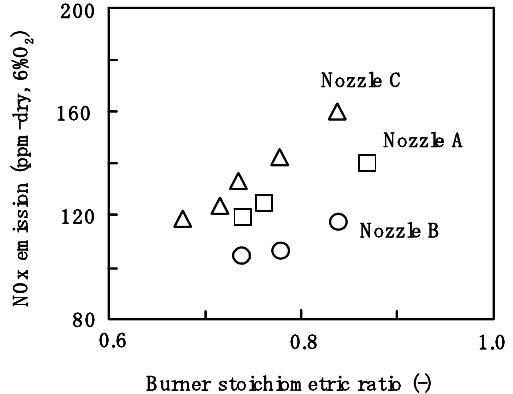
Figure 9. Comparison of NO stoichiometric ratios. Exit stoichiometric ratio was 1.15 for all experiments (exit O 2.7 vol%, dry).